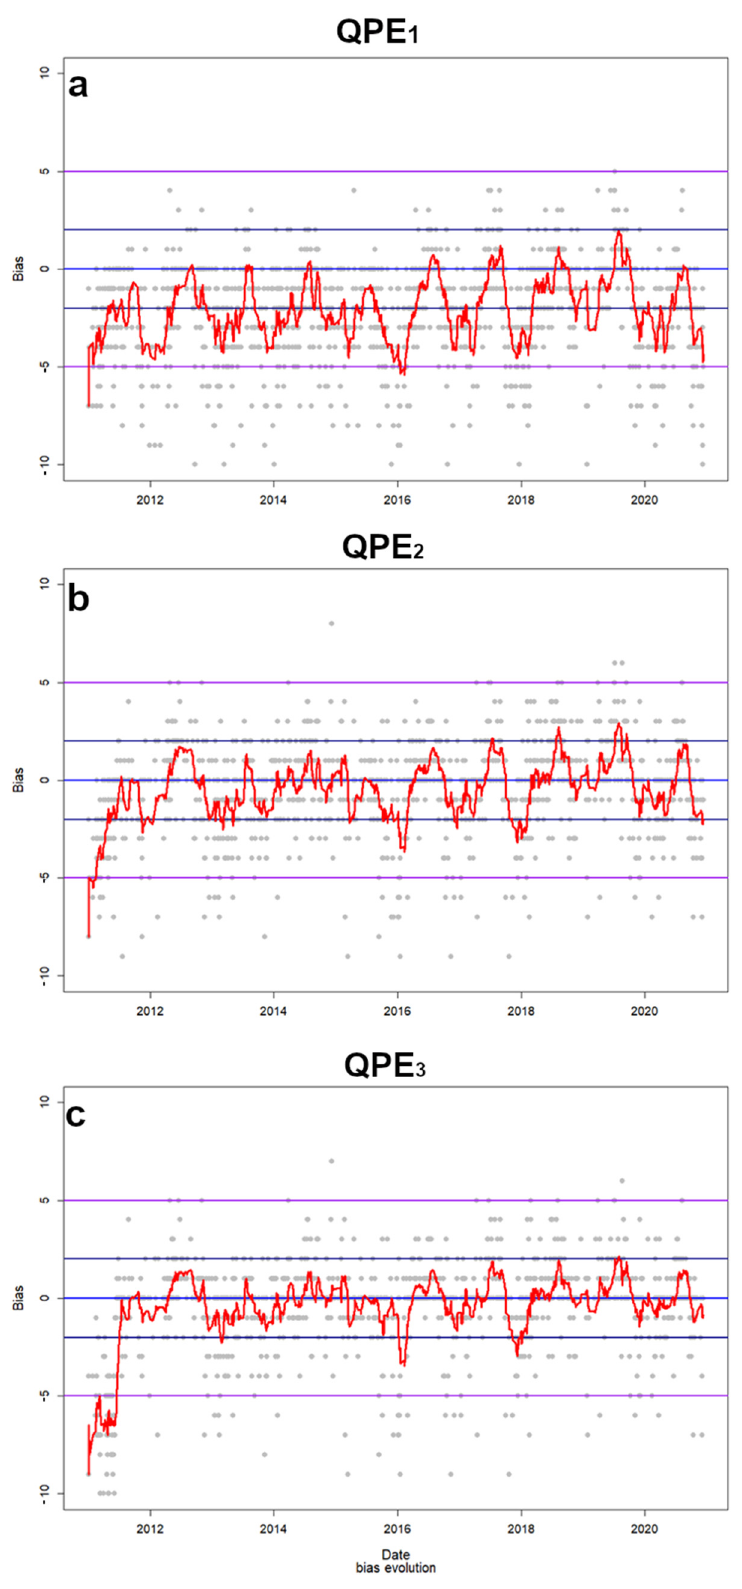
Figure 4. Same as Figure 3 but for the composite QPE (with simple corrections—panel ( a ), with EHIMI corrections—panel ( b ), and with EHIMI plus rain gauge corrections—panel ( c )).